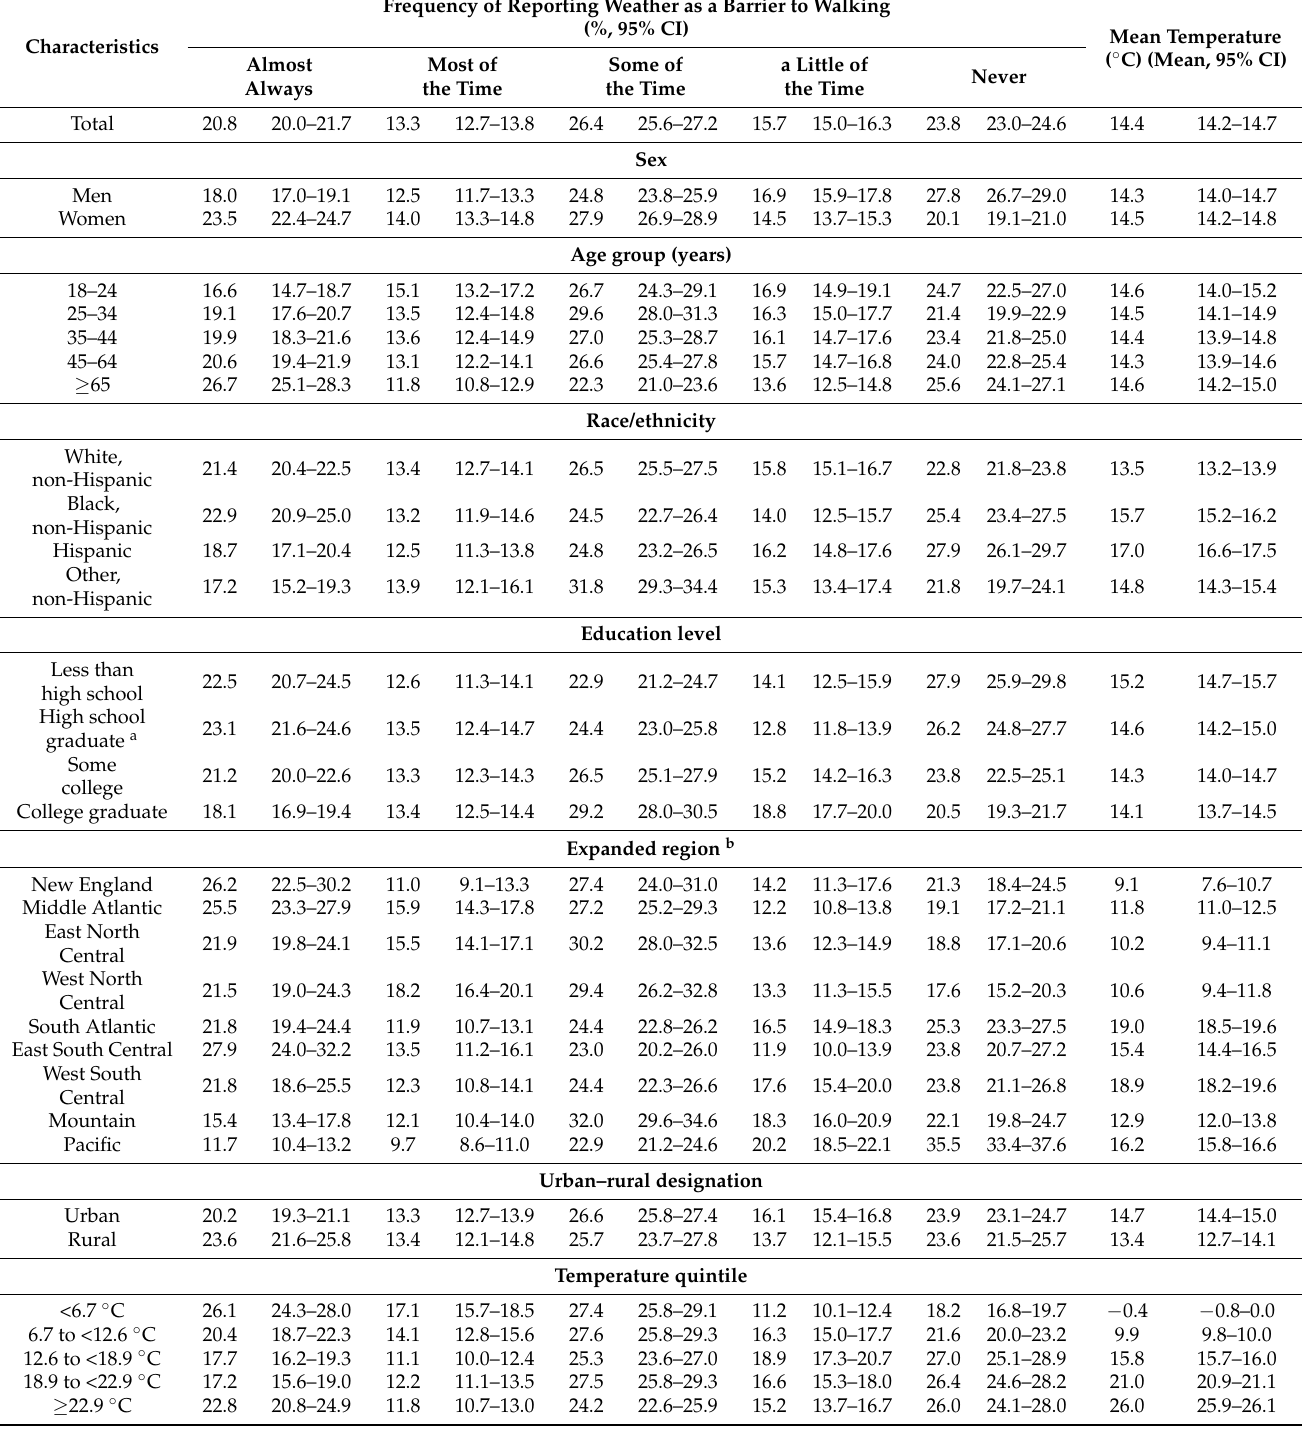
Table 1. Frequency of reporting weather as a barrier to walking and mean temperature by select characteristics.